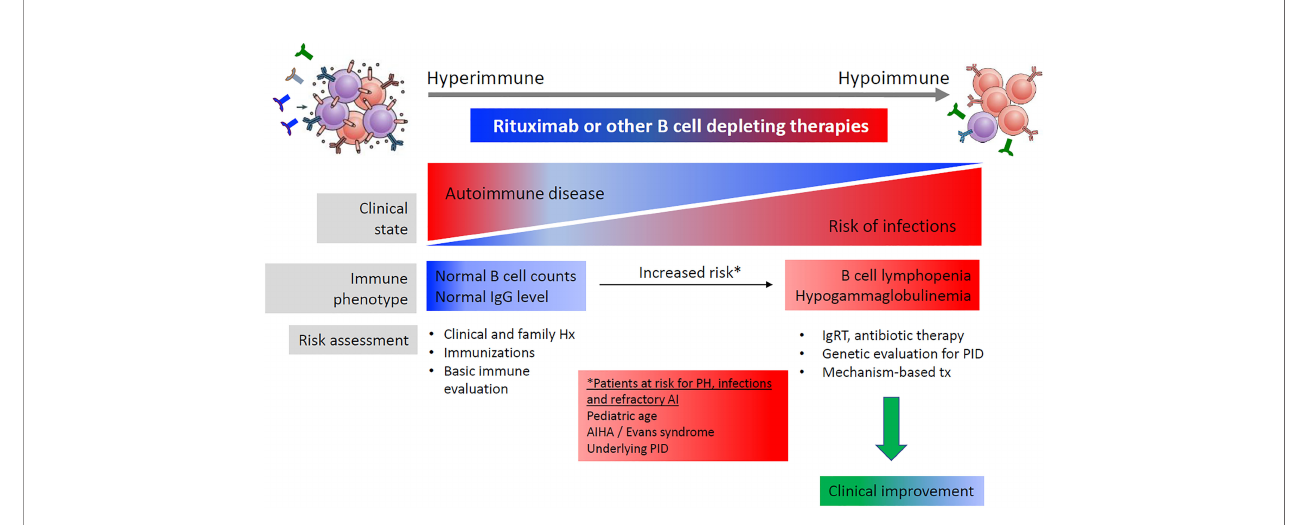
FIGURE 4 | B cell-related antibody responses to B cell-depleting therapy. Reproduced with permission from. (10)